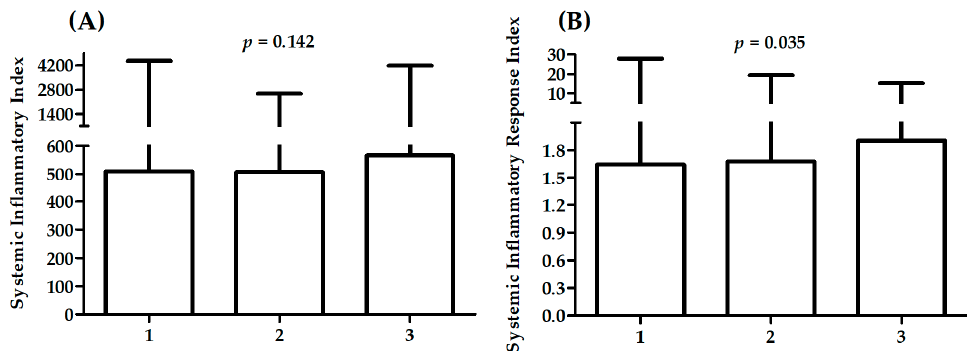
Figure 1. Differences in SII ( A ) and SIRI ( B ) between patients with different CASSC.